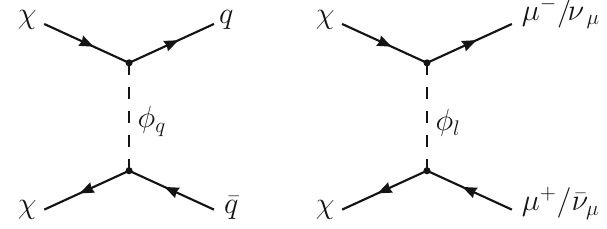
Fig. 2 Tree-level contributions to the DM pair